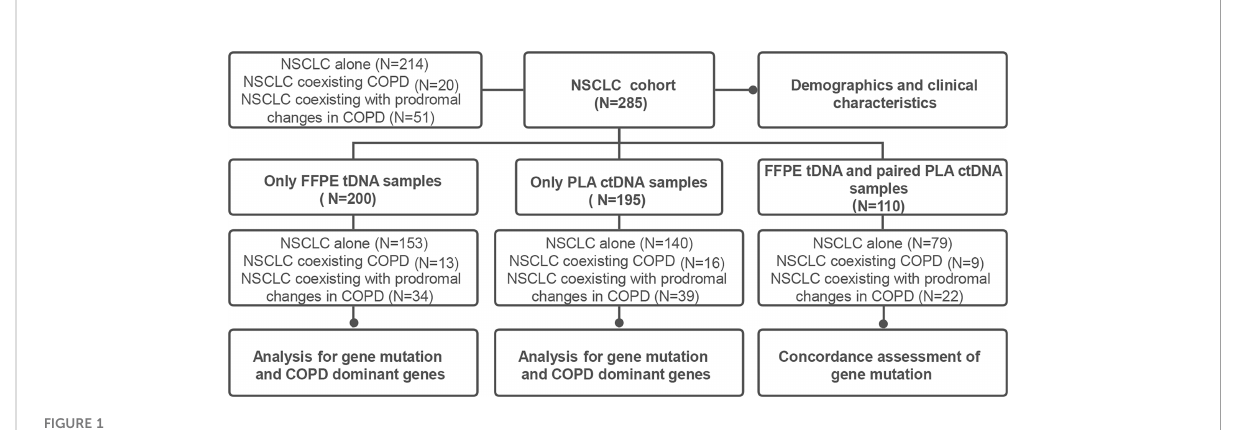
FIGURE 1 Overview of study design and sample size in our